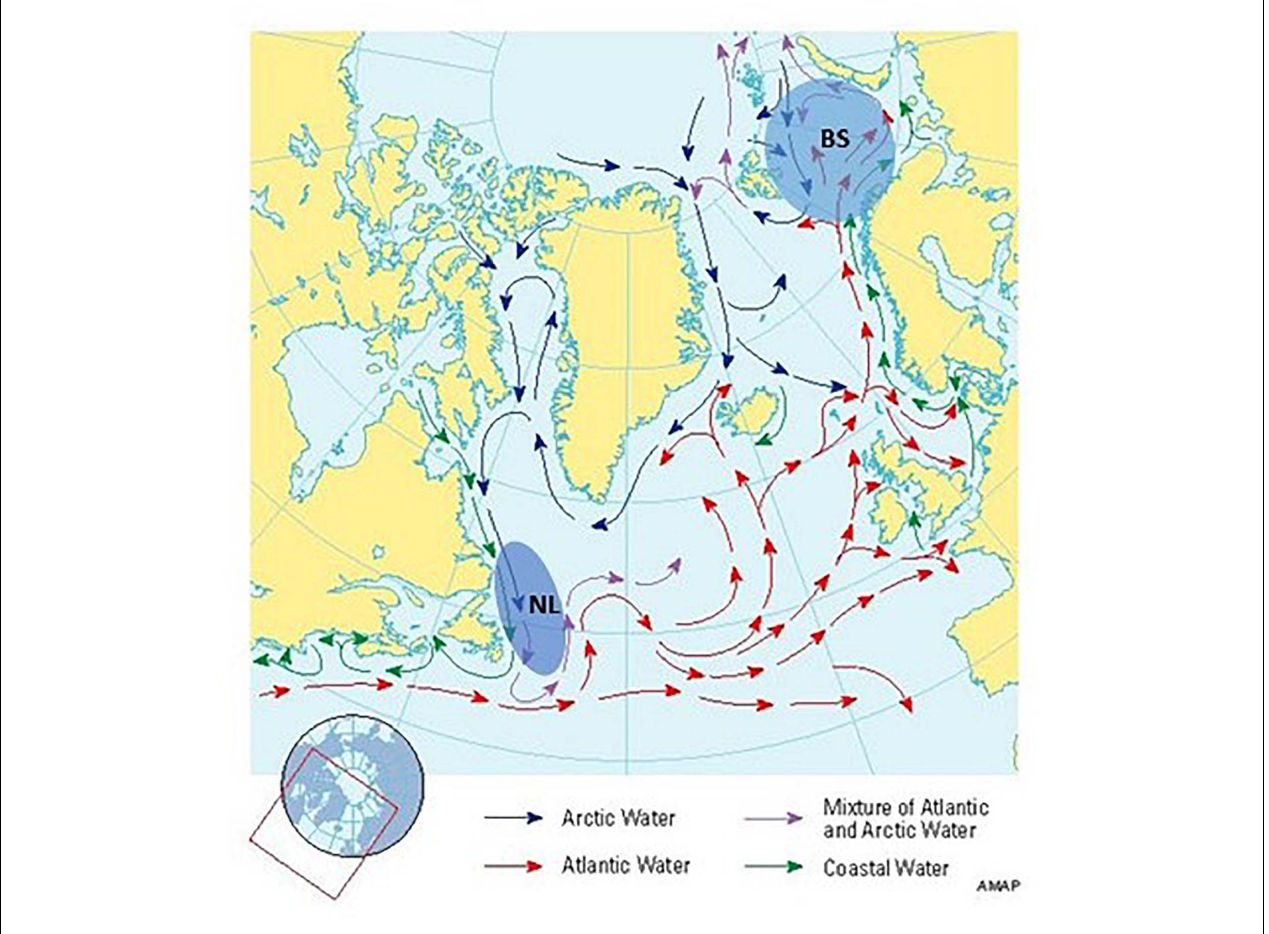
FIGURE 1 | Location of the two ecosystems, Newfoundland-Labrador shelves (NL) and Barents Sea (BS) (marked with ellipses), for which cod stocks are being compared in this study, with indication of major surface currents in the north Atlantic Ocean (AMAP